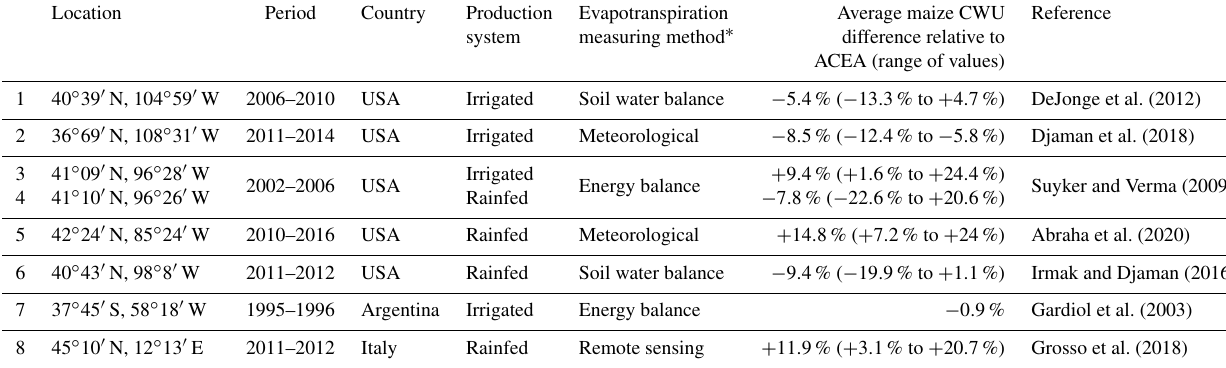
Table 4. Comparison of crop water use (CWU) of rainfed and irrigated maize with field studies. Location Period Country Production Evapotranspiration Average maize CWU Reference system measuring method ∗ difference relative to ACEA (range of